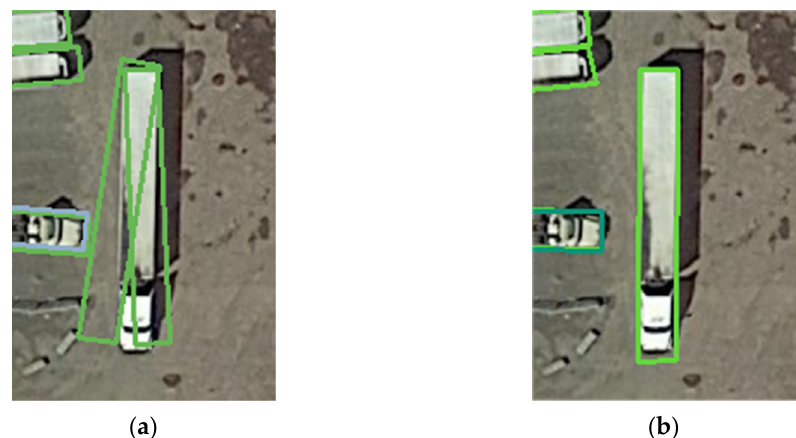
Figure 4. Examples of detection results with different regression methods: ( a ) detection result with R2CNN and ( b ) detection result with TPR-R2CNN.